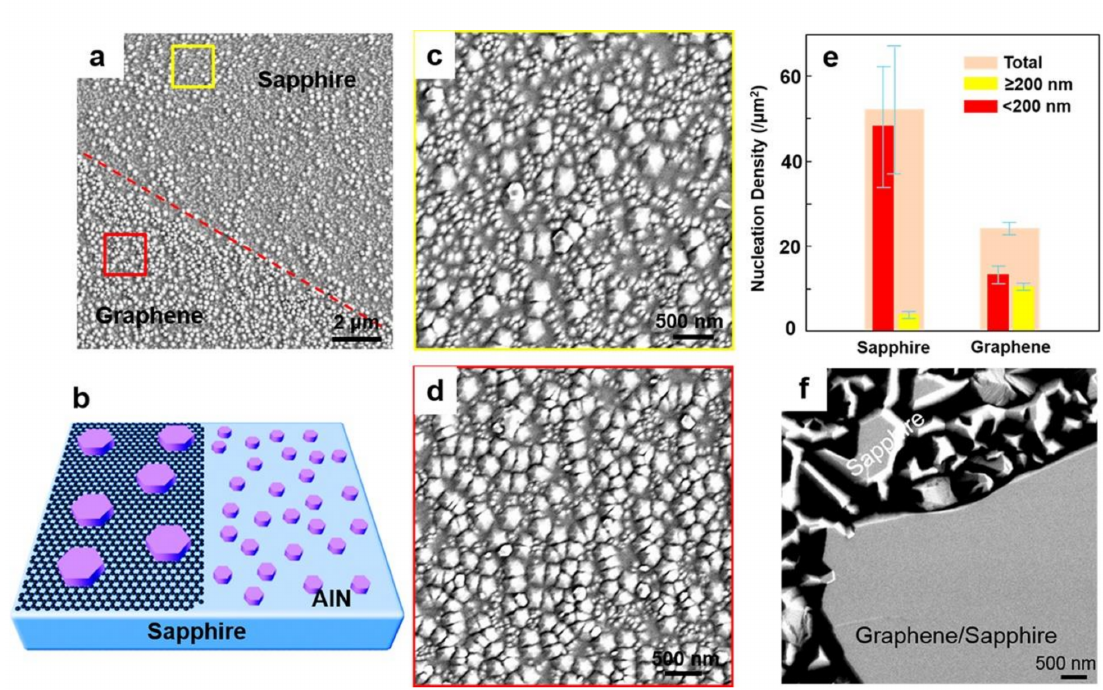
Figure 19. ( a ) SEM image of AlN nucleation on bare sapphire and graphene-buffered sapphire; ( b ) Schematic diagram of AlN nucleation on bare sapphire and graphene-buffered sapphire. Enlarged SEM images of AlN nucleation on ( c ) bare sapphire and ( d ) graphene-buffered sapphire; ( e ) compar- ison of the density and size of AlN nucleus on bare sapphire and graphene-buffered sapphire; ( f ) SEM morphology of AlN grown on bare sapphire and graphene-buffered sapphire. Reprinted with permission from [93]. Copyright {2018} American Chemical Society.